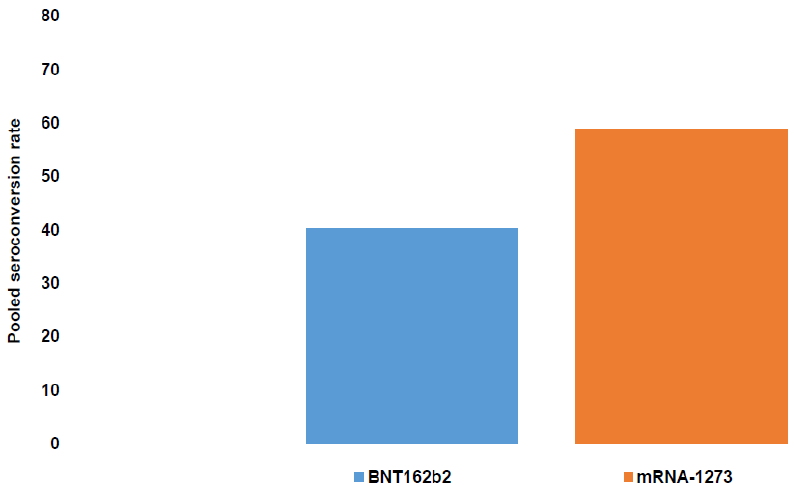
Figure 1. Relative seroconversion rate of BNT162b2 compared with mRNA-1273 = 79.5%. A study by Liefeldt [11] examined the predictors of the serological response to SARS- CoV-2 vaccination in kidney transplant patients. The study found that predictors of a weak response were the age at vaccination, time after kidney transplantation, immunosuppres- sion, estimated glomerular filtration rate (eGFR) at vaccination and lymphocyte count at vaccination (Table 1a). The time after transplantation had an important role in the immune response, because, in the early period, the higher immunosuppression and the higher inci- dence of rejection may prevent or reduce the immune response. The use of mycophenolate further impaired the response to vaccination and the authors hypothesized that erythrocyte IMPDH activity could be used to monitor mycophenolate treatment (Table 1b). Table 1. ( a ) Multivariate analysis of factors associated with the serological response to vaccination after kidney transplantation according to the study of Liefeldt et al. [11]; ( b ) multivariate analysis of factors associated with the serological response to vaccination after kidney transplantation in MPA-treated patients after KTx transplantation.